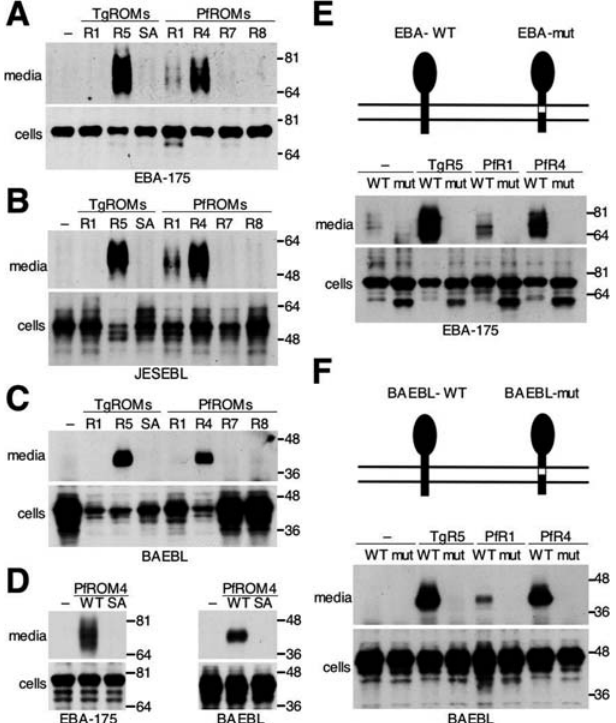
Figure 4. Cleavage of P. falciparum EBLs by Parasite Rhomboid Enzymes TgROM5 and PfROM4, as well as PfROM1, to a lesser extent, were able to cleave EBA-175 (A), JESEBL (B), and BAEBL (C), as assessed by anti-GFP Western analysis of media from transiently transfected COS cells. (D) Mutating the active site serine of PfROM4 to alanine (SA) abolished EBA- 175 and BAEBL cleavage. The importance of the top of the trans- membrane domain of EBA-175 (E) and BAEBL (F) for cleavage by parasite rhomboid enzymes was assessed by Western analysis of media fractions from COS cells transiently transfected with the wildtype (WT) and mutant (mut) adhesins. In all cases, mutation of the corresponding trans- membrane sequences to AITALVVVIS from TGF a (white region in diagram) abolished adhesin cleavage by TgROM5, PfROM1, and PfROM4. Molecular weight standards in kDa are denoted to the right of each panel. DOI: